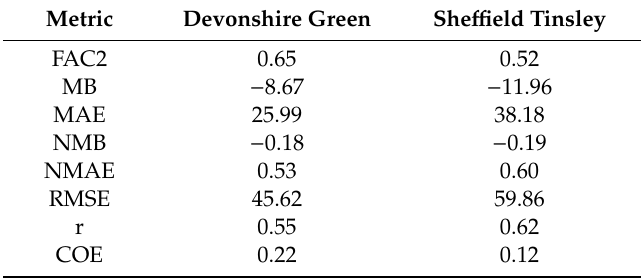
Table 5. The value of various statistical metrics used for assessing the performance of the model for predicting NOx concentrations in the month of January 2017 at both Devonshire Green and She ffi eld